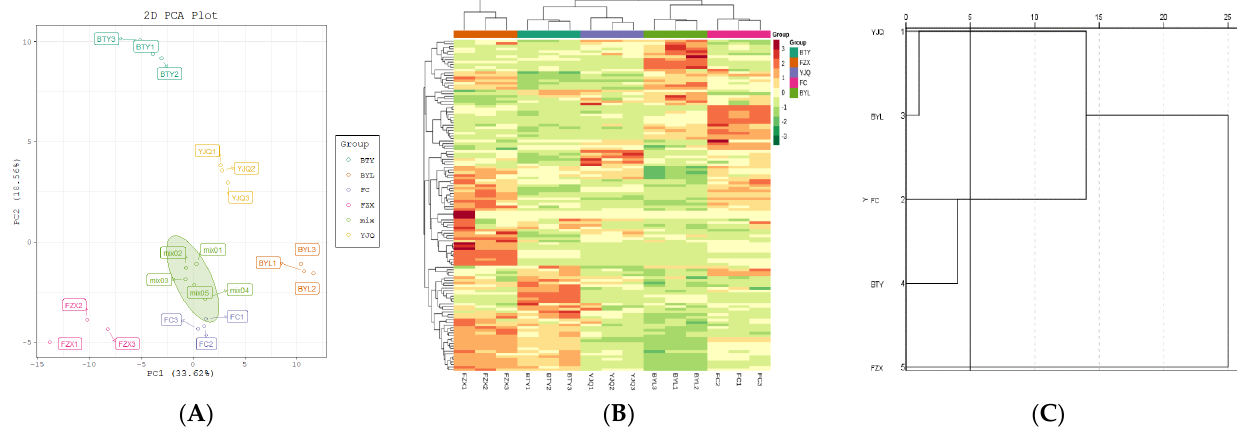
Figure 4. PCA score plot and cluster map of polyphenol metabolites in different litchi cultivars. ( A ) PCA score plot; ( B ) Cluster heat map. The color sequence from red to dark green indicates metabolites abundance from high to low; ( C ) Cluster analysis chart, genealogy using average join (between groups), rescaled distance clustering combination.